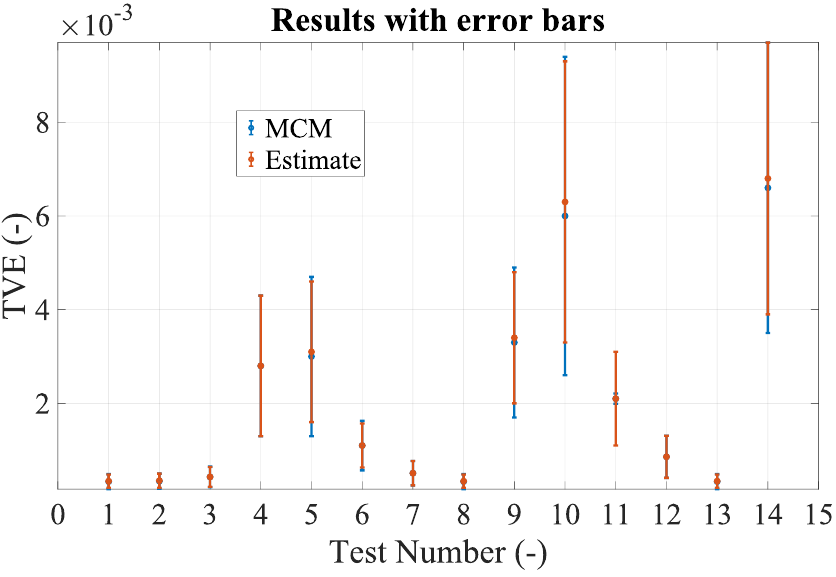
Figure 3. Test results presentation with error